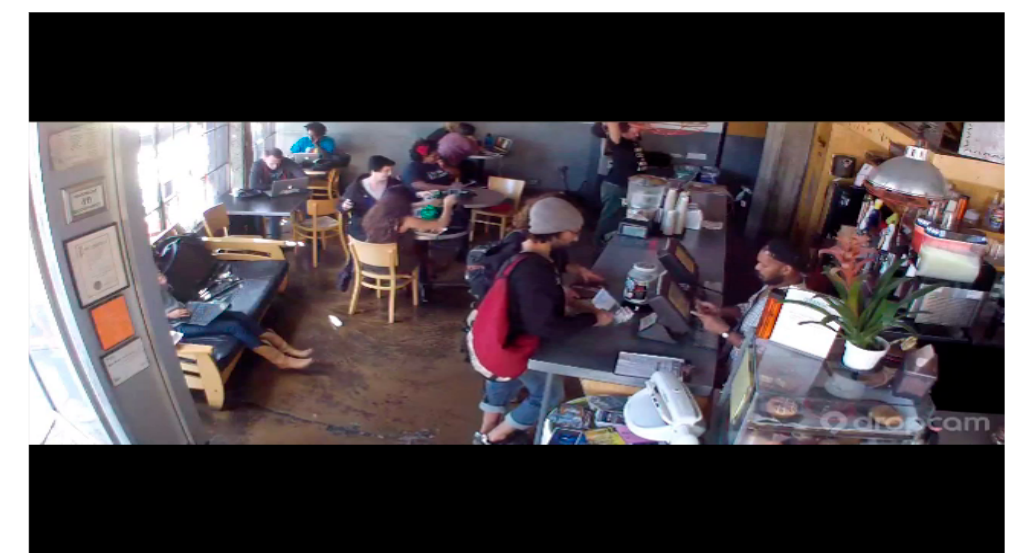
Figure 2. An image in brainwash dataset.